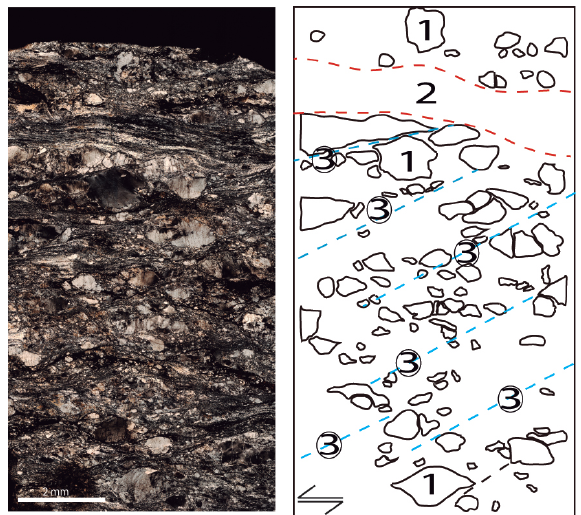
Figure 3. Cross-polarized optical micrograph showing the mi- crostructure of sample PE19 from the Pernambuco shear zone. K- feldspar porphyroclasts (domain 1) alternate with monomineralic quartz veins (domain 2). Dark layers of ultrafine-grained feldspathic mixture form an anastomosing network wrapping the porphyro- clasts and are particularly well developed in a C’ orientation consis- tent with the sinistral sense of shear (domain 3). See text for further